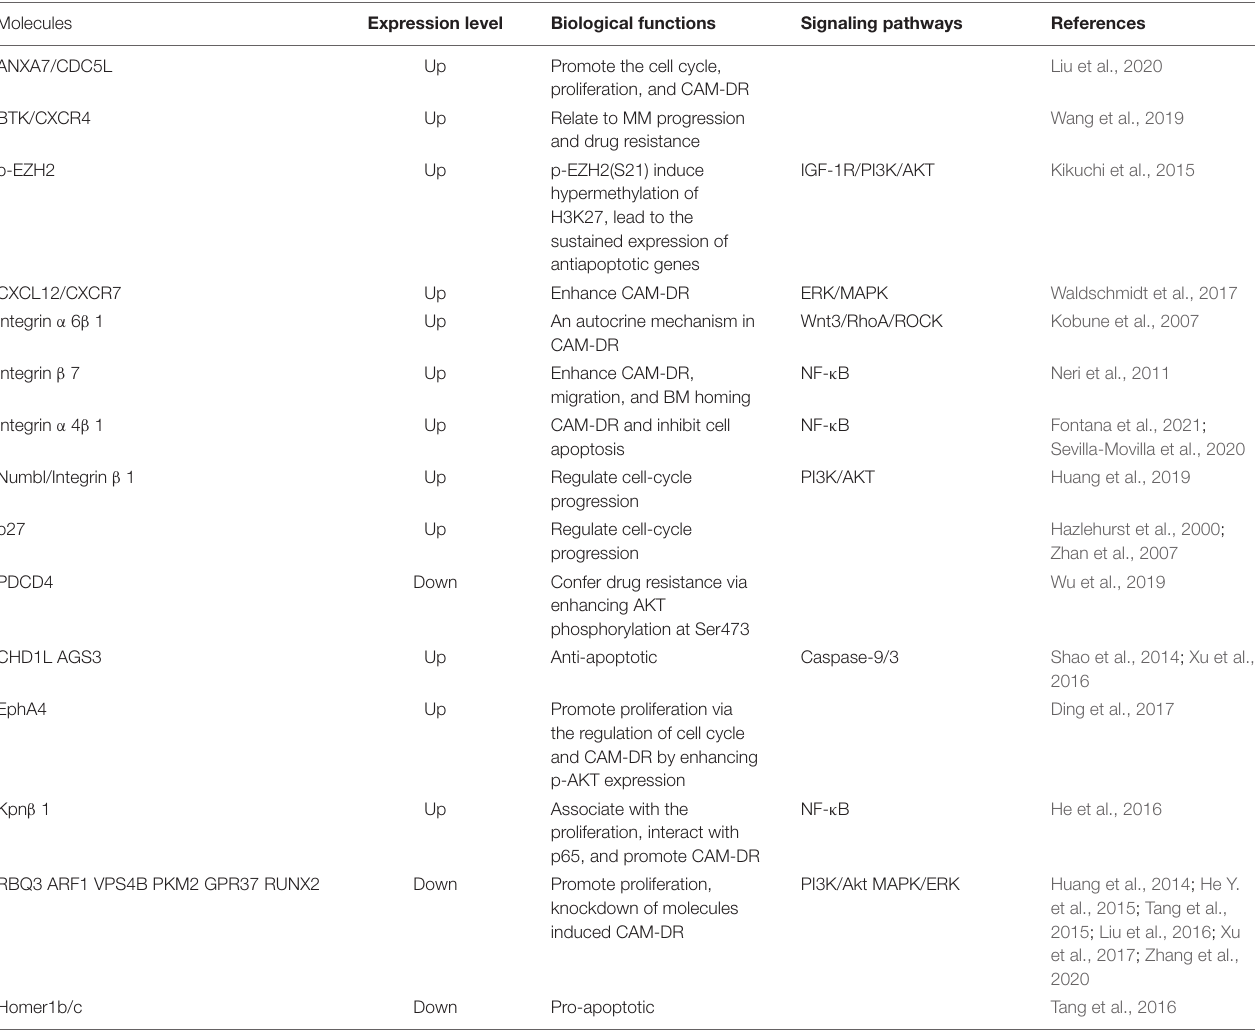
TABLE 1 | CAM-DR in